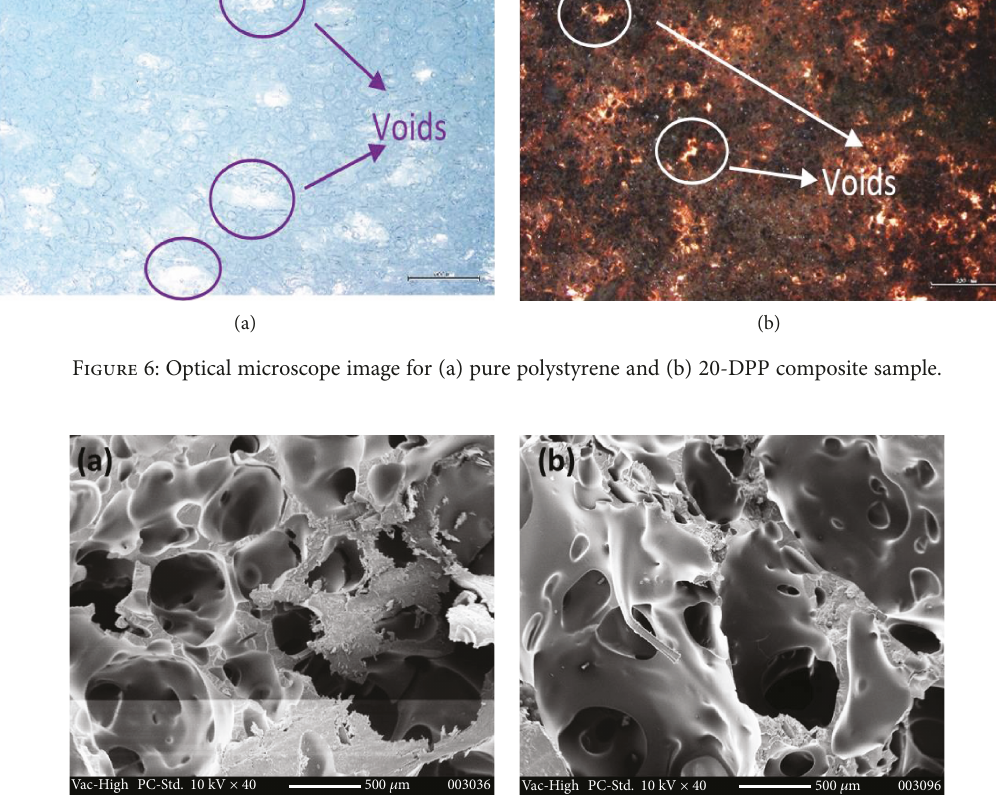
Vac-High PC-Std. 10 kV Figure 7: SEM for (a) pure polystyrene and (b) 20-DPP composite sample.